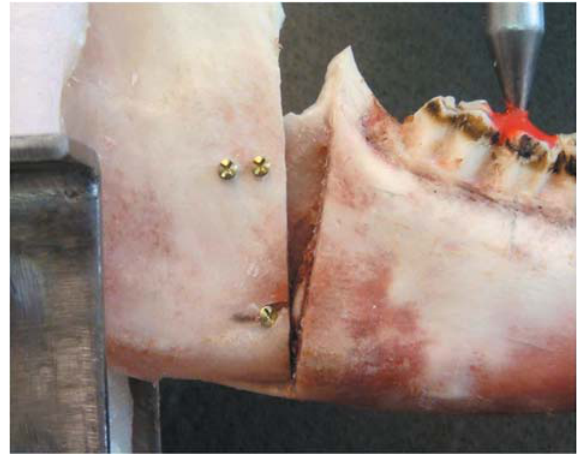
Figure 7- Fracture of the mandible after the application of force